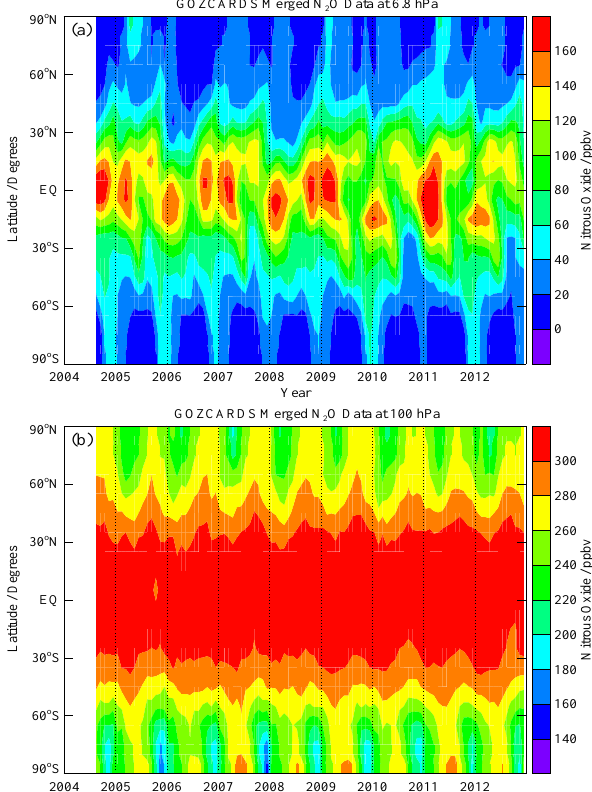
Figure 23. Time evolution (August 2004 through 2012) versus latitude of GOZCARDS merged N 2 O (ppbv) at (a) 6.8hPa and (b)